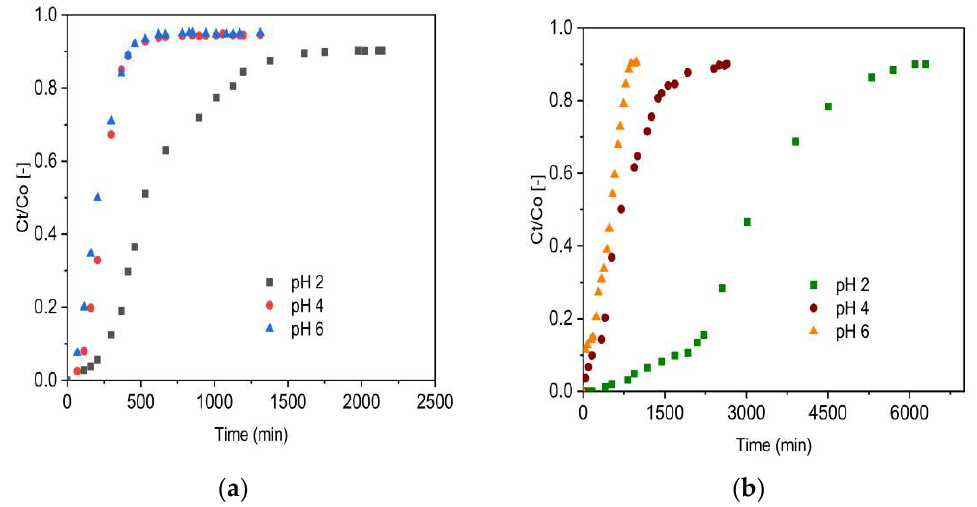
Figure 5. Effect of solution pH on fluoride breakthrough ( a ) VSco and ( b ) ZrOCSc (initial fluoride concentration 10 mg/L (C O : 10 mg/L); initial flow rate 1.25 mL/min (Q O : 1.25 mL/min); bed depth 10 cm).